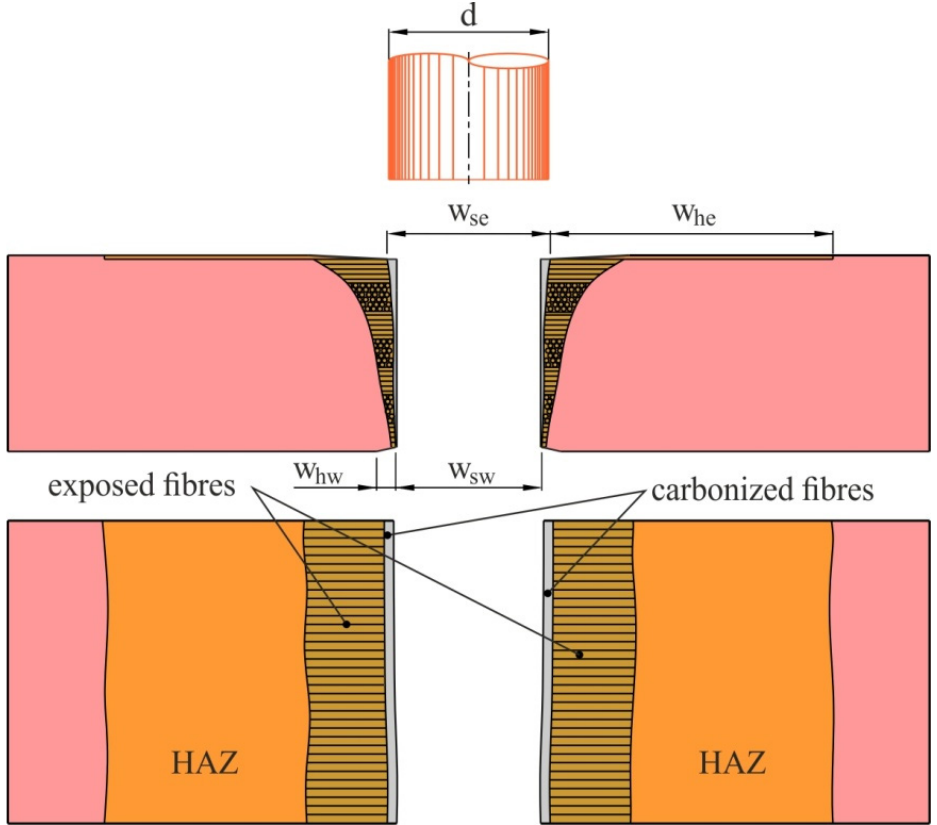
Figure 2. A typical composite surface after laser cutting (adapted with permission from Ref. [43]. 1988, copyright Taylor & Francis).